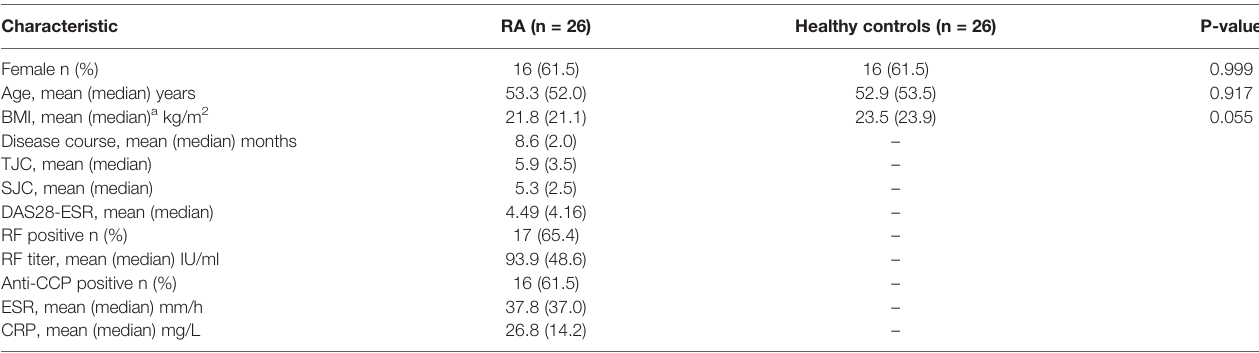
TABLE 1 | Main demographic, clinical, and laboratory data of RA patients and healthy